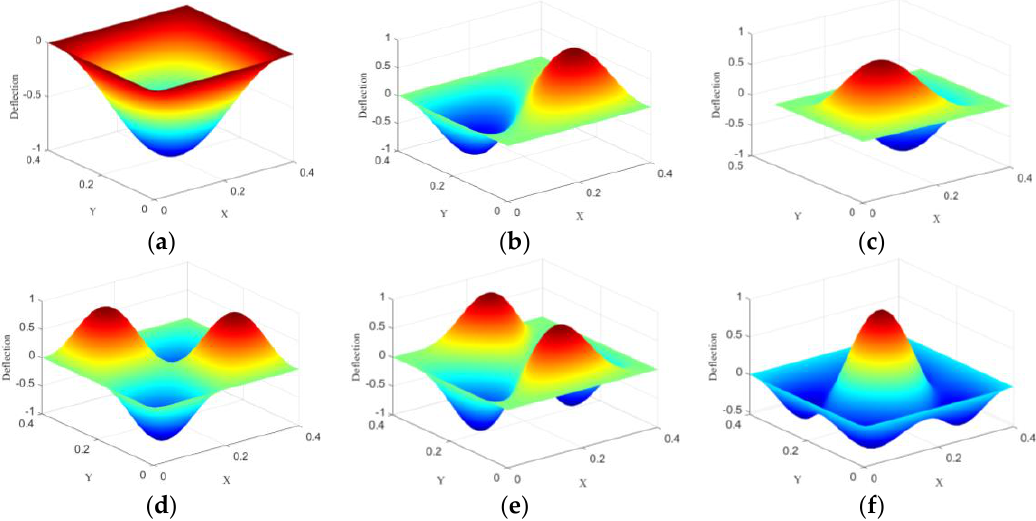
Figure 5. First six mode shapes of a simply supported PFGP: ( a ) Mode 1; ( b ) Mode 2; ( c ) Mode 3; ( d ) Mode 4; ( e ) Mode 5; ( f ) Mode 6. Table 2. The lowest 10 natural frequencies (Hz) of a SSSS PFGP with different control meshes. Mode